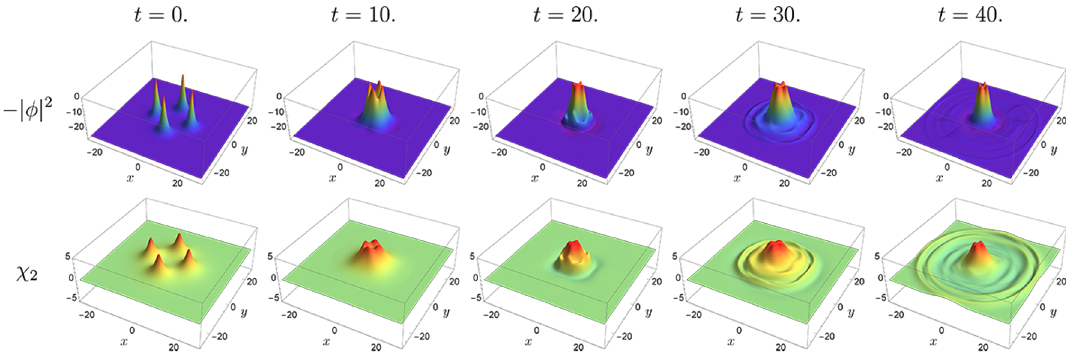
Figure 40 . Snapshots of −| φ | 2 and χ 2 for the scattering of n = 4 type I* non-Abelian vortices with parallel internal orientations and initial velocity u = 0 . 5